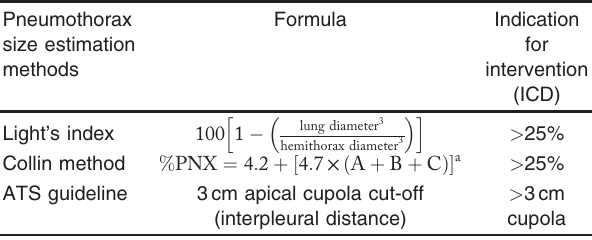
Table 1 Comparison of guidelines of size estimation of pneumothorax Pneumothorax size estimation methods